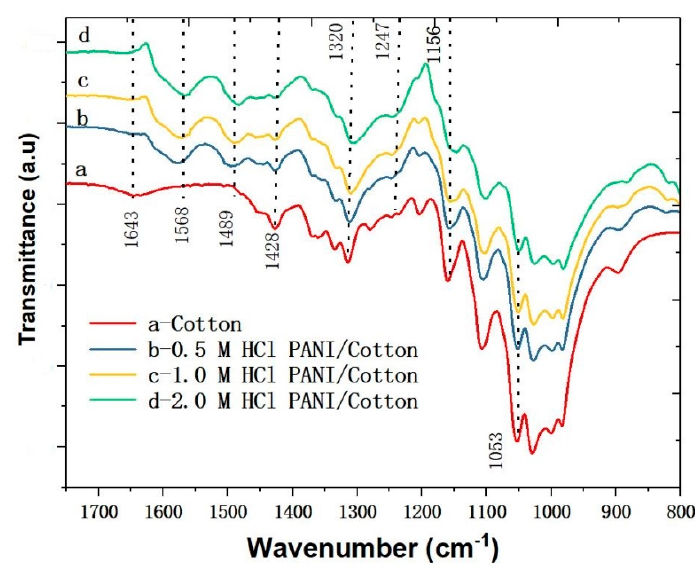
Figure 3. Infrared absorption spectra of the PANI-coated fabrics.